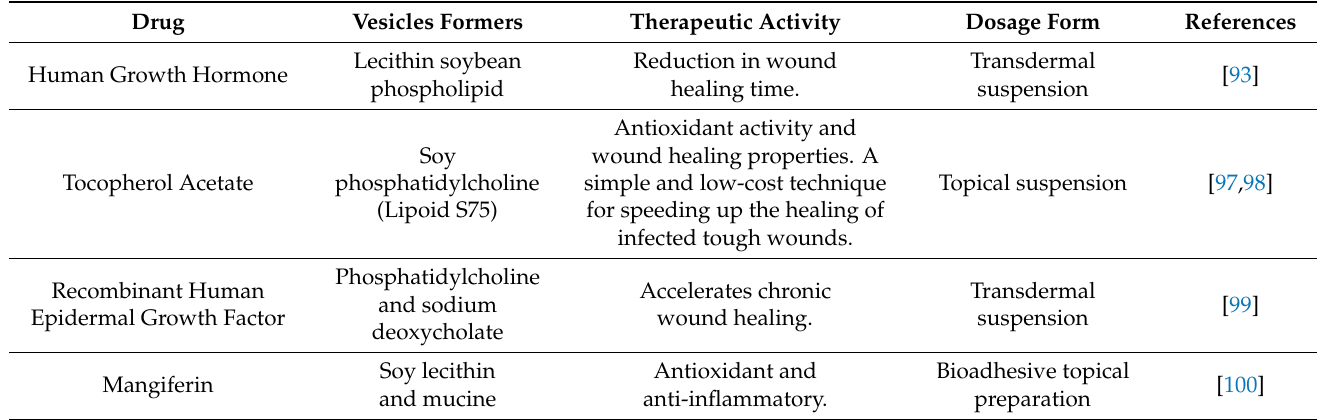
Table 7. Examples of transfersome drug delivery systems for burn